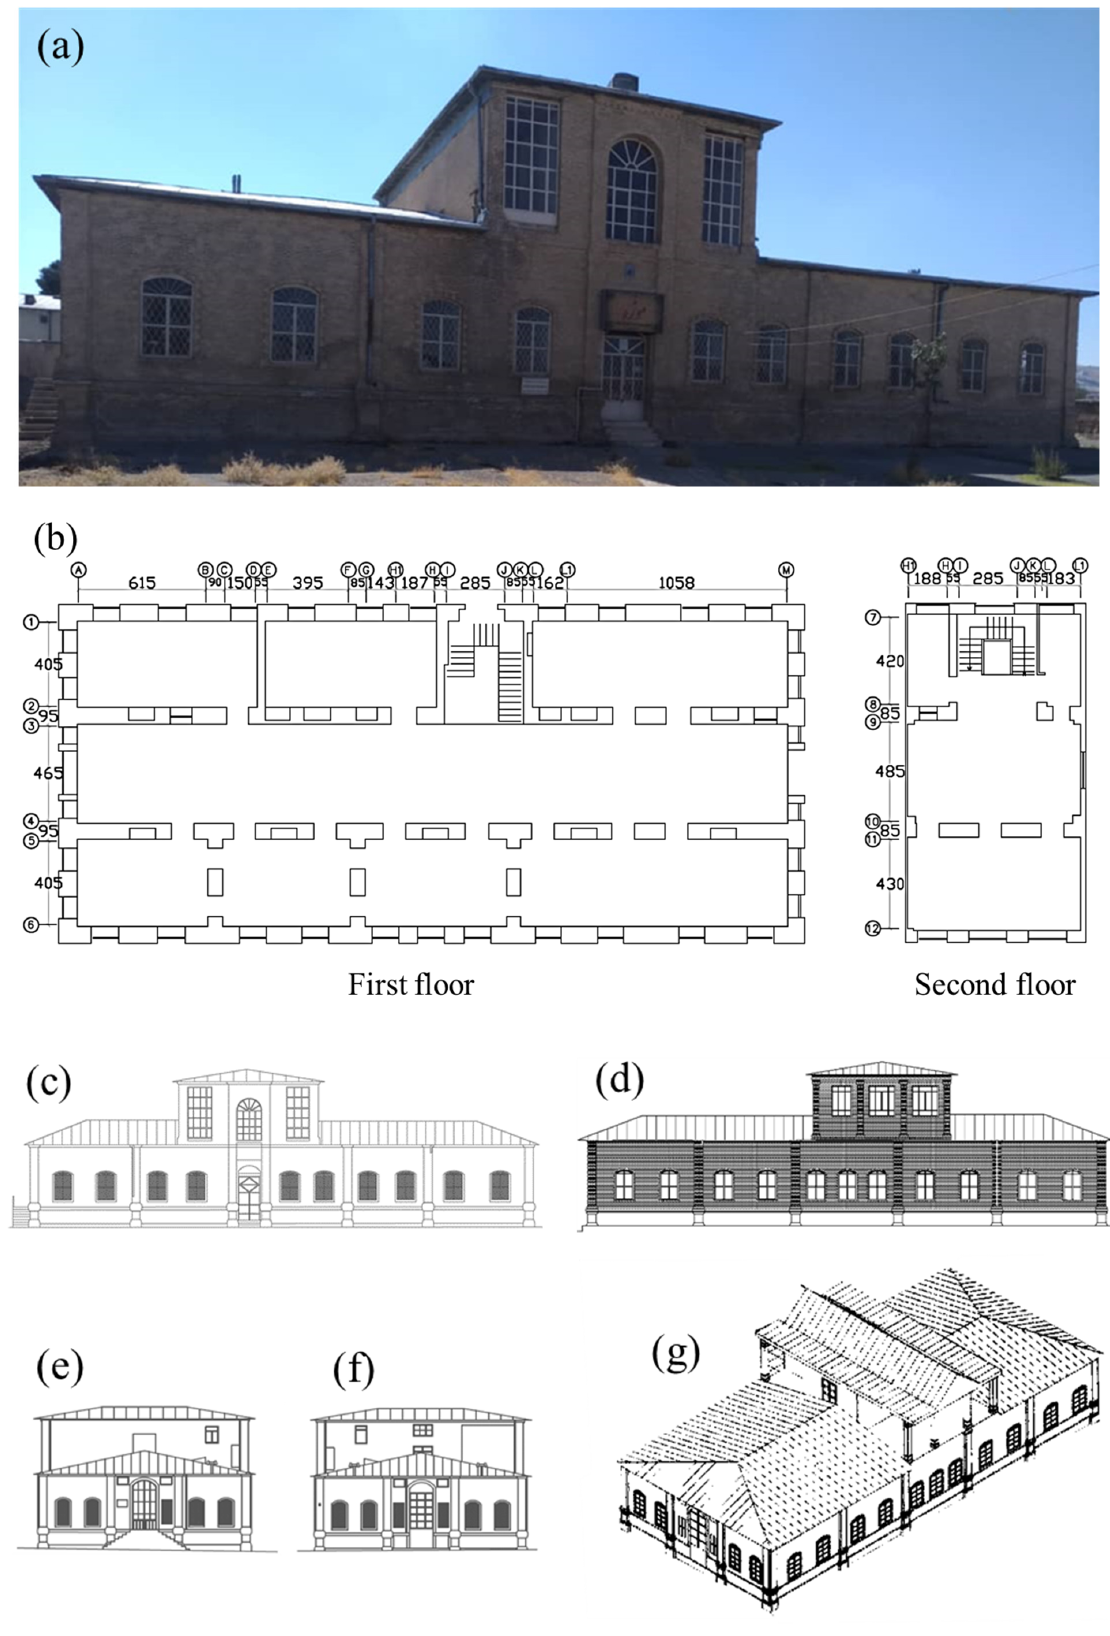
Figure 1. Kazazi High School: ( a ) north-view photo, ( b ) first-floor and second-floor plan (dimensions in centimeter), ( c ) north-view, ( d ) south-view, ( e ) east-view, ( f ) west-view, and ( g ) building perspective.